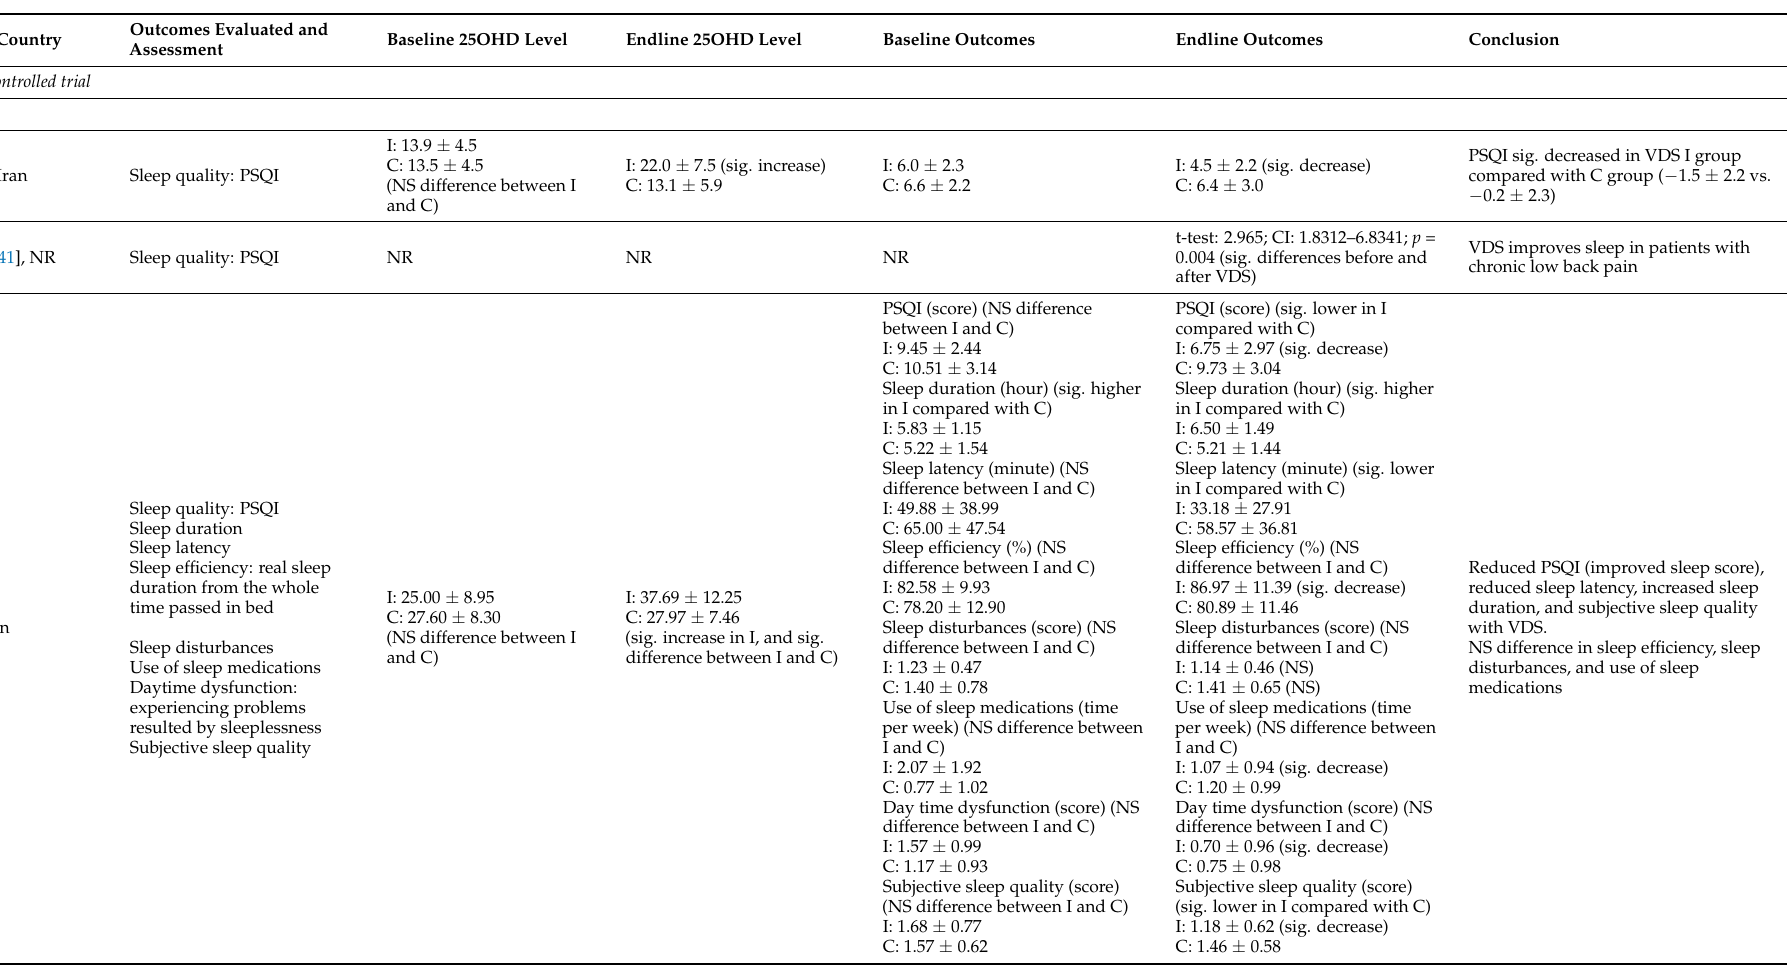
Table 2. Results of included